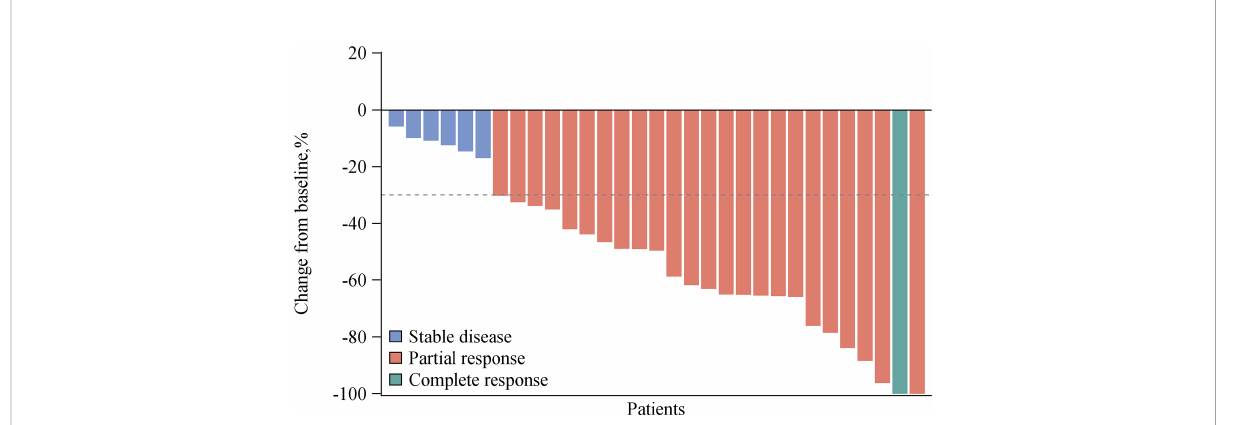
FIGURE 1 Overall response of pucotenlimab with gemcitabine plus cisplatin as assessed by investigators (N = 31).